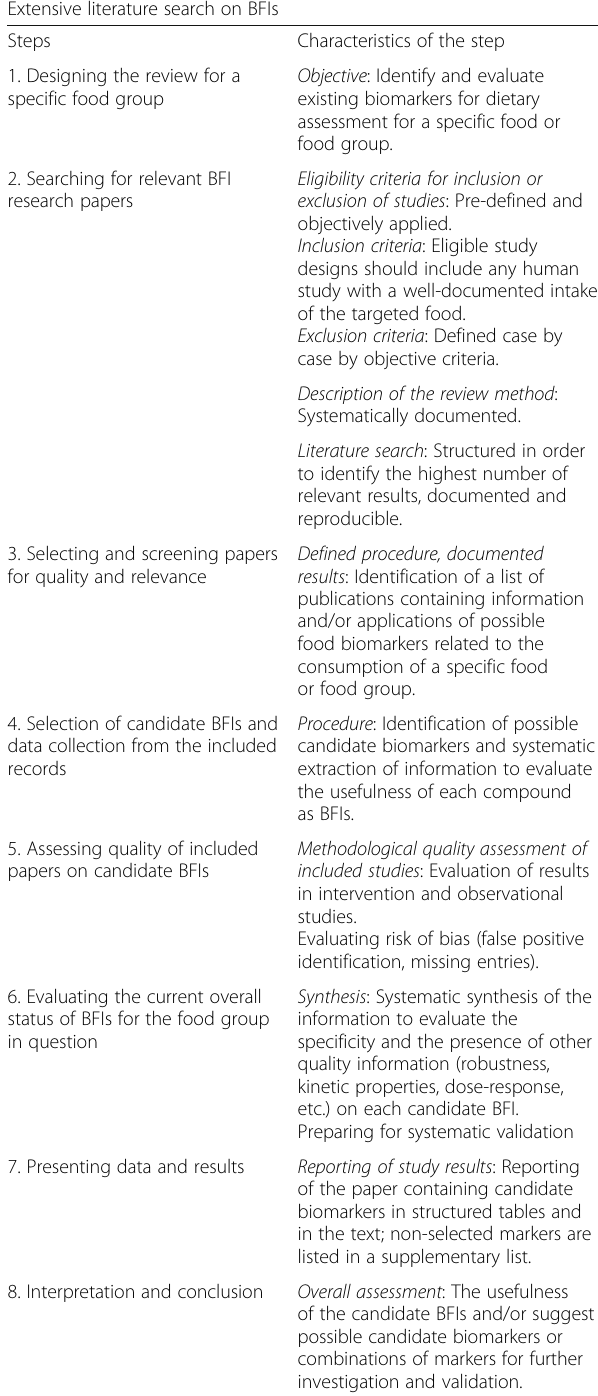
Table 2 Typical features of an extensive literature search methodology on